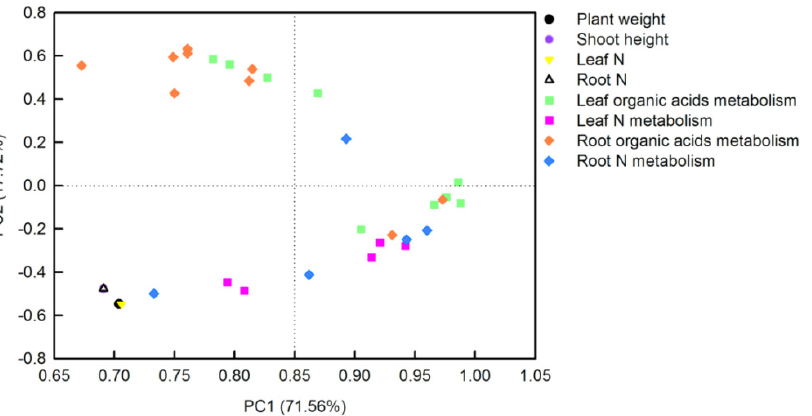
Figure 7. P rincipal component analysis (PCA) loading plot of the parameters in O. sativa leaves sand roots under different N levels. Thirty-two parameters from O. sativa leaves and roots were trans- formed for PCA analysis. The first two PCs explained 89.28% of the physiological variation in re- sponse to different N-supplying